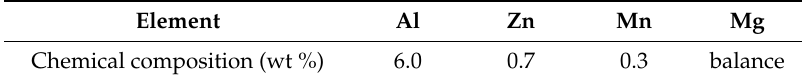
Figure 3. Potentiodynamic curves of ground (#1200) and polished (0.25 µm) surface of AZ31 and AZ61 magnesium alloys in enriched HBSS+ (with Mg 2+ and Ca 2+ ions).